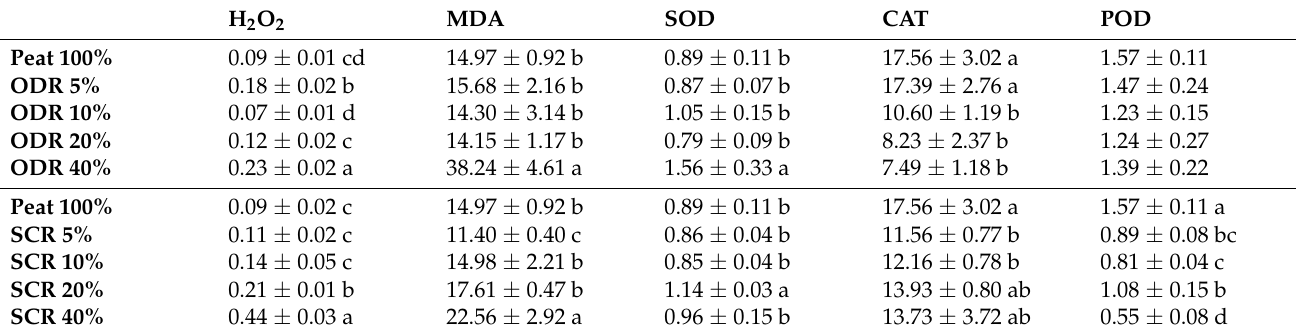
Table 6. Effects of growing media (Peat, O. dubium residue—ODR, and S. cypria residue—SCR) on hy- drogen peroxide—H 2 O 2 ( µ mol/g), lipid peroxidation—MDA (nmol/g) and the antioxidant enzyme activity of superoxide dismutase (SOD; units/mg of protein), catalase (CAT; units/mg of protein), and peroxidase (POD; units/mg of protein) in sowthistle plants grown in a